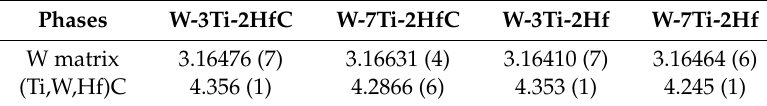
Table 4. Lattice parameters of W-Ti alloy in sintered samples.